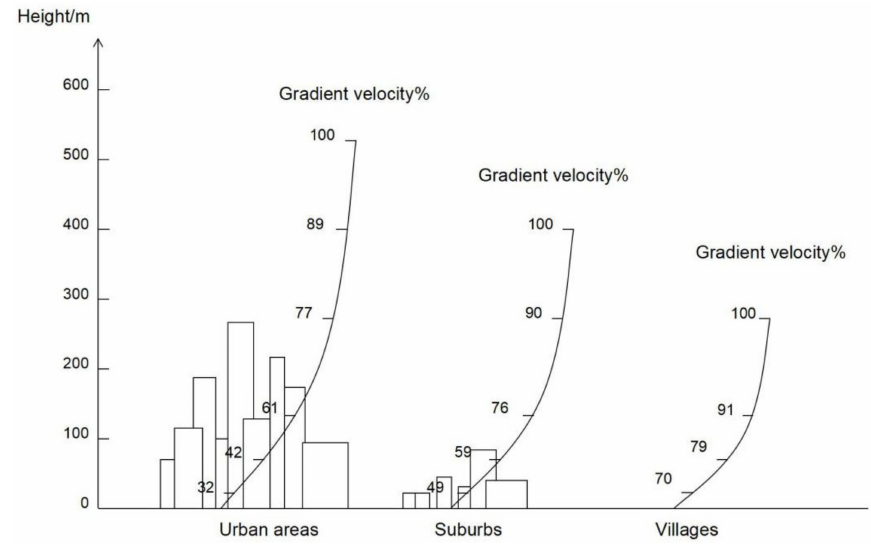
Figure 7. Variation of gradient wind at different roughness.